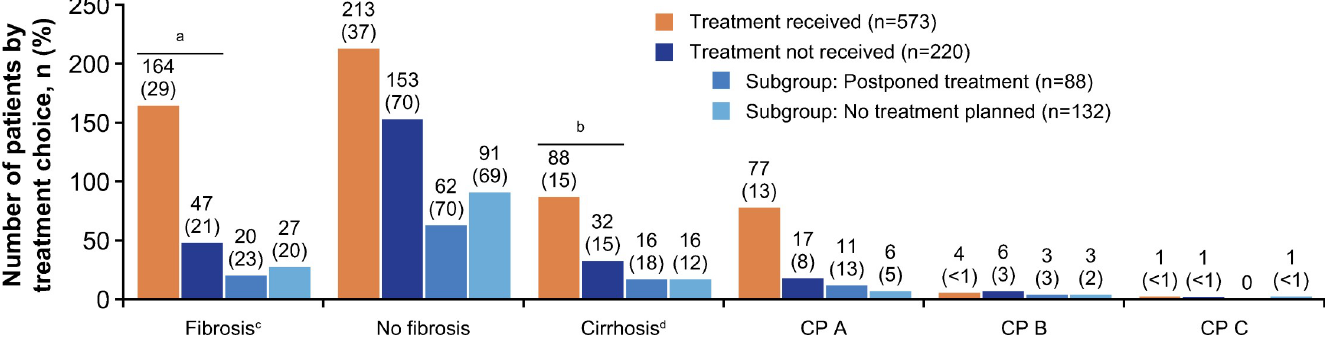
Fig 1. Fibrosis and cirrhosis status in patients with CHC virus infection. a P = 0.001; b P = 0.925 (received treatment vs treatment not received, two-sided Chi-square test); c Fibrosis status was unknown in 6–196 (7–34%) of patients; d CP status was unknown in 2–8 (0.7–5%) of patients with cirrhosis. CHC, chronic hepatitis C virus; CP, Child-Pugh.